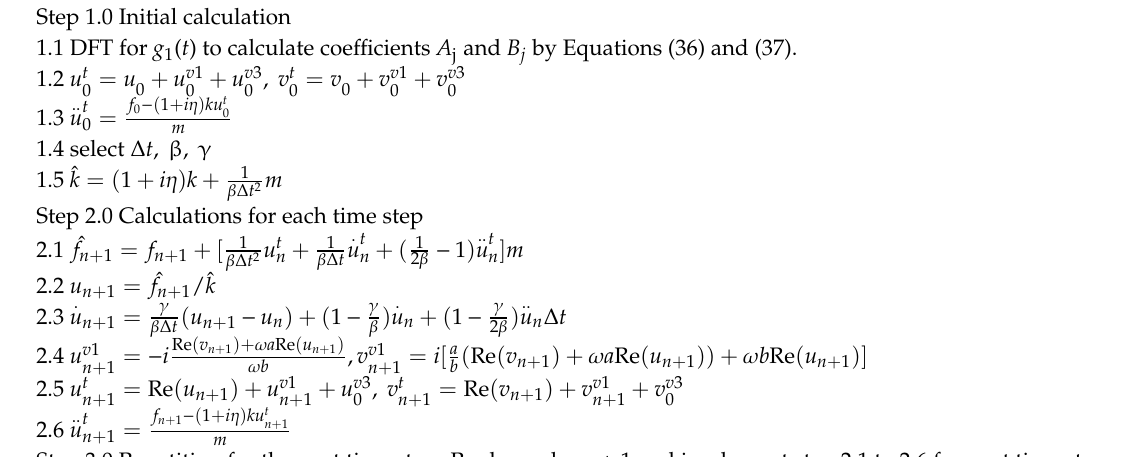
Algorithm 1 Newmark method with the virtual initial condition for arbitrary